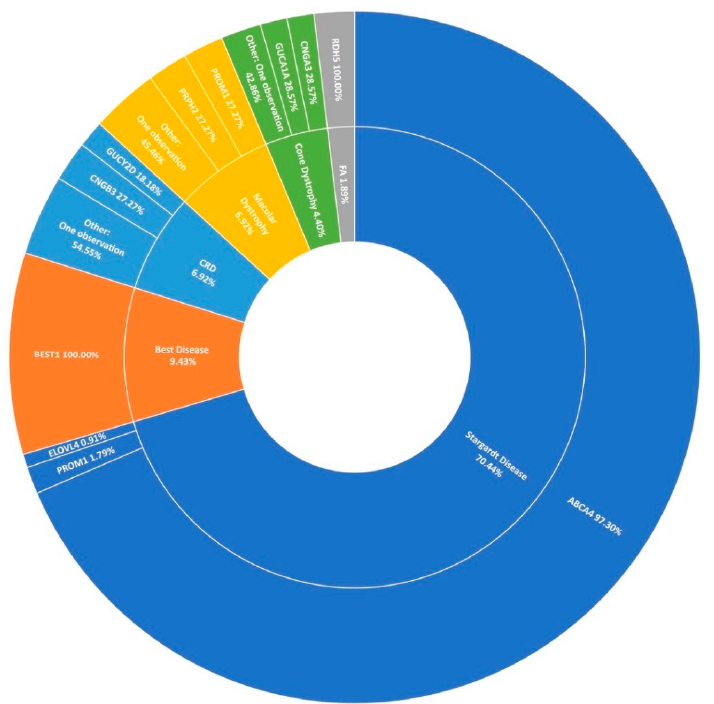
Figure 6. A summary of the genetic architecture of macular dystrophies in Target 5000 participants. CRD: Cone-Rod Dystrophy FA: Fundus Albipunctatus (Table S5).